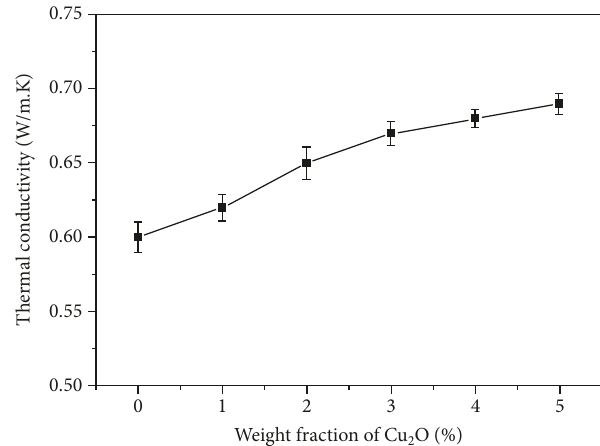
Figure 10: Relationship between the thermal conductivity of ce- ment composites and weight fraction of added nanostructured Cu 2 O